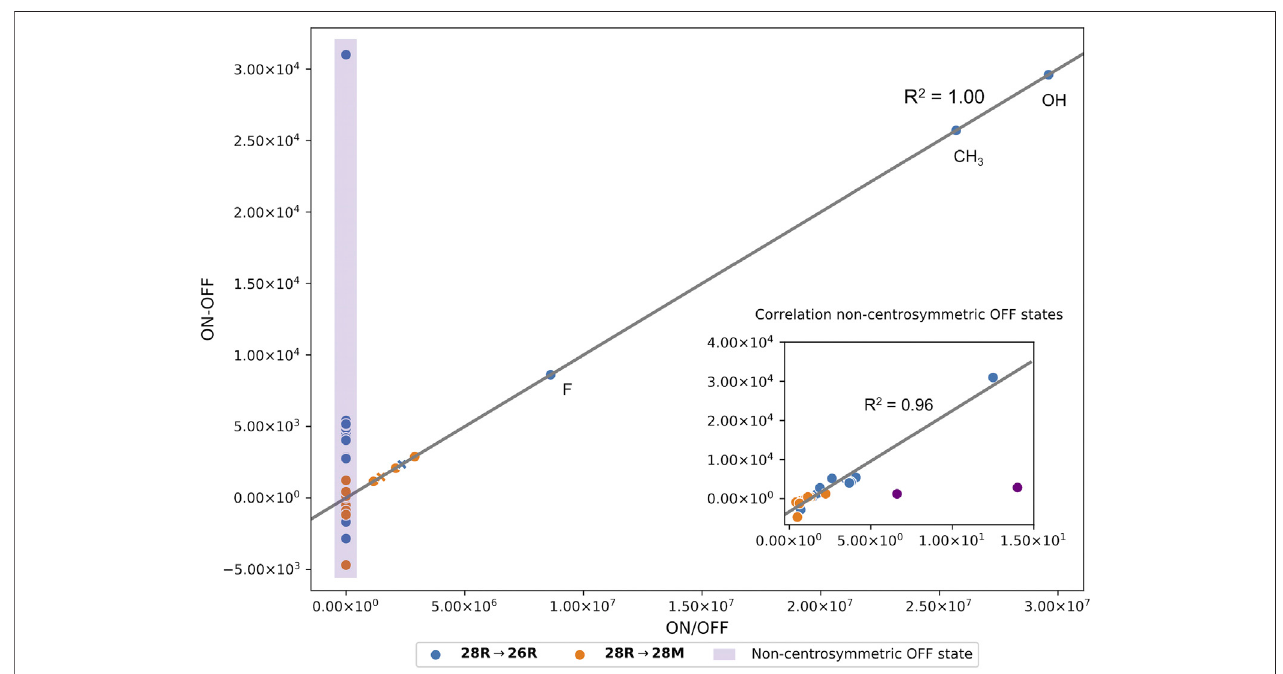
FIGURE5| Correlationplotbetweenthetwocontrastde fi nitionsbasedontheratioandthedifferenceofthe β HRS responsesofallmeso-substitutedstructureswith a centrosymmetric OFF state ( R 2 of 1.00). The datapoints marked with an X are the unsubstituted hexaphyrins. All switches with a non-centrosymmetric OFF state are highlighted in the purple box. A separate plot in the right corner shows the correlation of these systems ( R 2 of